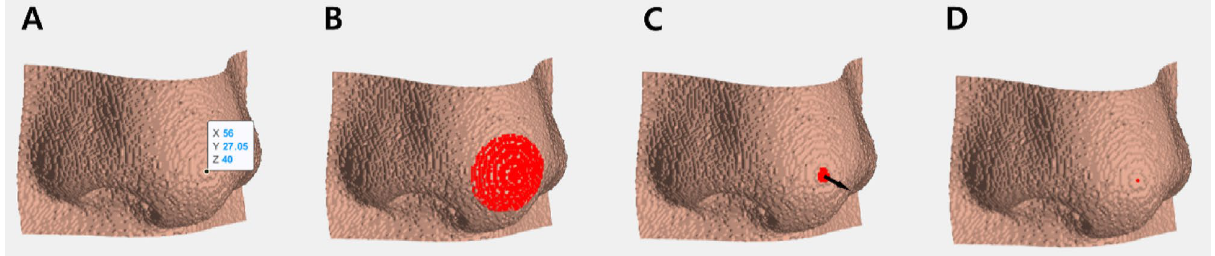
Figure 4. The process of obtaining the CC points of pronasale (left-sided view). ( A ) Manual coordinate determination of pronasale. ( B ) From the points taken manually, the points within 50 pixels of Euclidean distance were first obtained. ( C ) Tabletop plane including the coordinates of the points taken manually representing normal vector (black arrow). ( D ) Average coordinates of the points on the tabletop plane obtained.